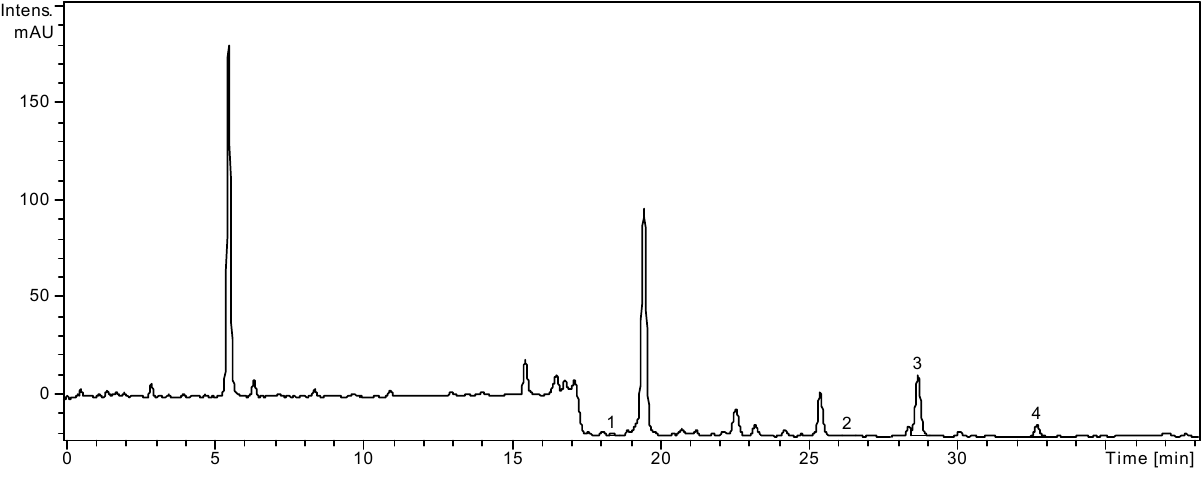
Figure 2. HPLC chromatogram of A. distans subsp. alpina.